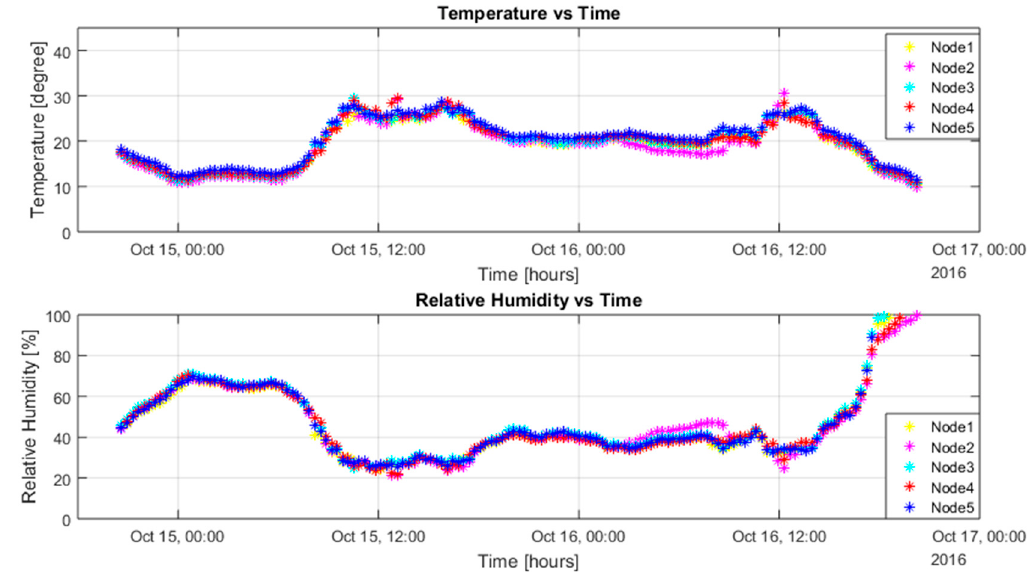
Figure 7. Battery-powered sensor nodes’ performance.